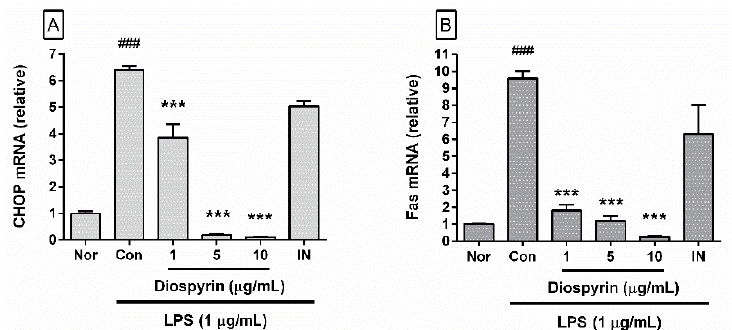
Figure 4. Effect of diospyrin on mRNA expression of C/EBP homologous protein (CHOP) ( A ) and Fas ( B ) in LPS-induced RAW 264.7 were measured with real-time RT-PCR after 18 h incubation with compounds. β -actin was used as the housekeeping gene. Nor, normal group (media only); Con, control group (LPS alone). IN denotes indomethacin (0.5 μ M). Values are the mean ± SD of three independent experiments. ### p < 0.001 vs. Nor; *** p < 0.001 vs. Con.